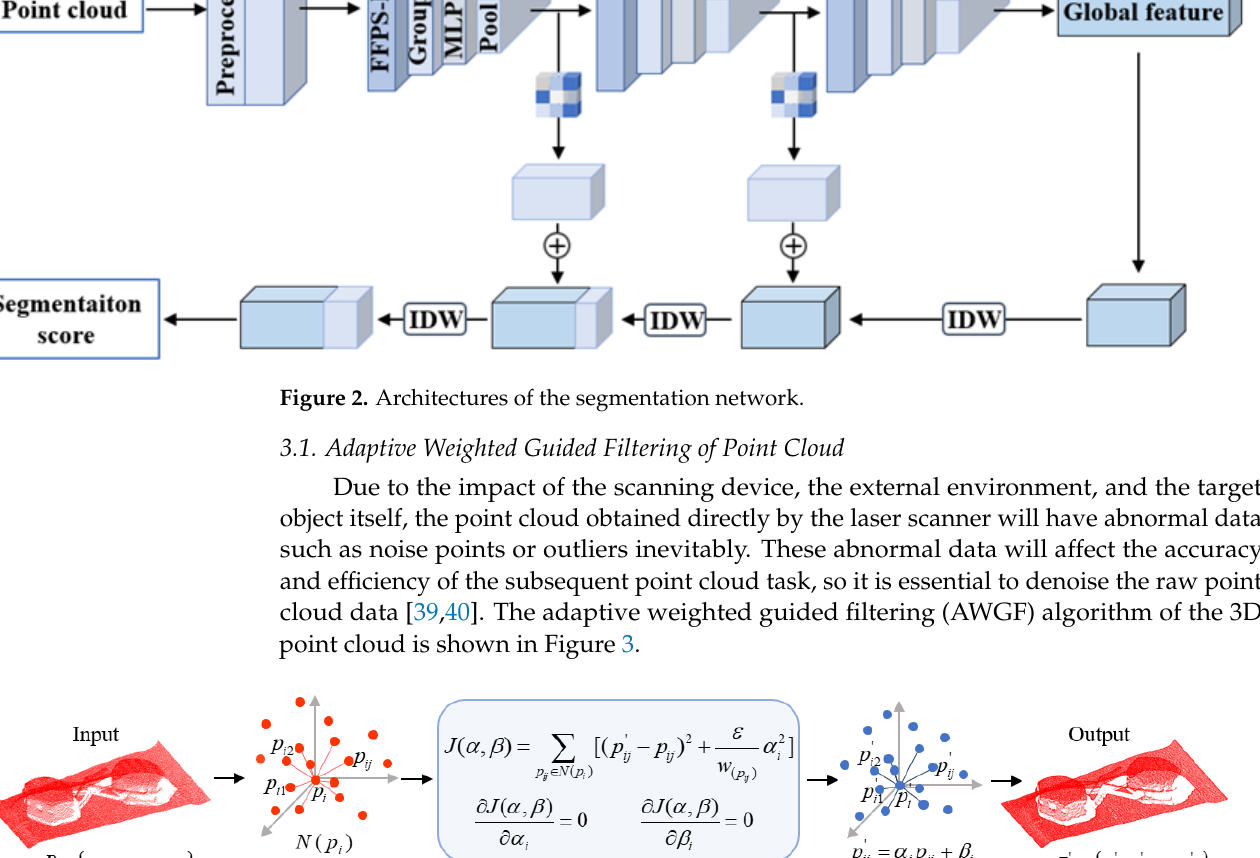
Figure 2. Architectures of the segmentation network.